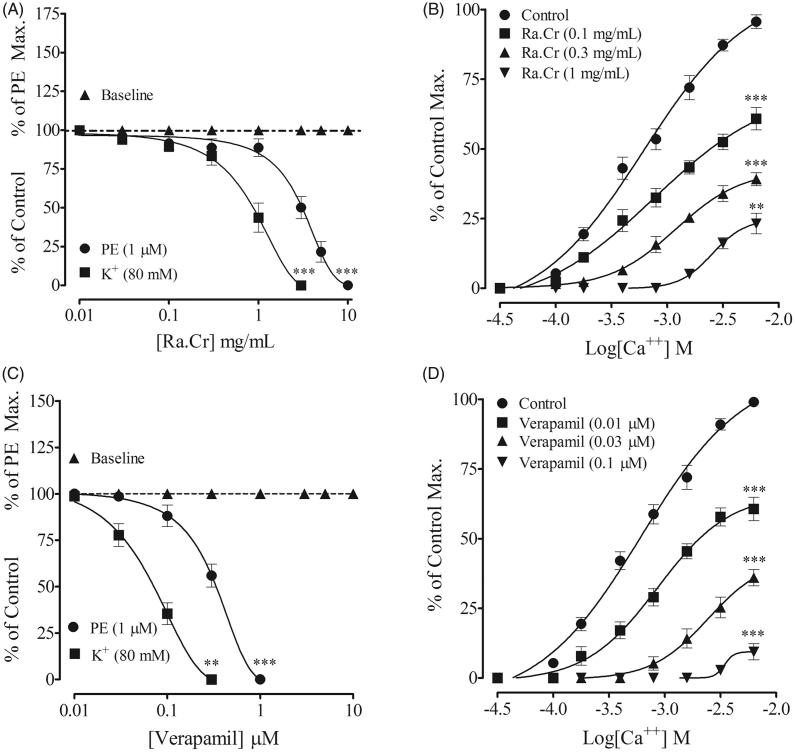
Concentration-dependent vasorelaxant response of (A) the crude extract of Rumex acetosa (Ra.Cr); (C) verapamil on phenylephrine (PE 1 µM) and K+ (80 mM) precontractions and on baseline tension, (B,D) respectively, their effect on the sigmoidal CaCl2 concentration–response curves, constructed in Ca2+-free medium, in isolated rabbit aorta preparations. Values shown are mean ± SEM. Five to six determinations.